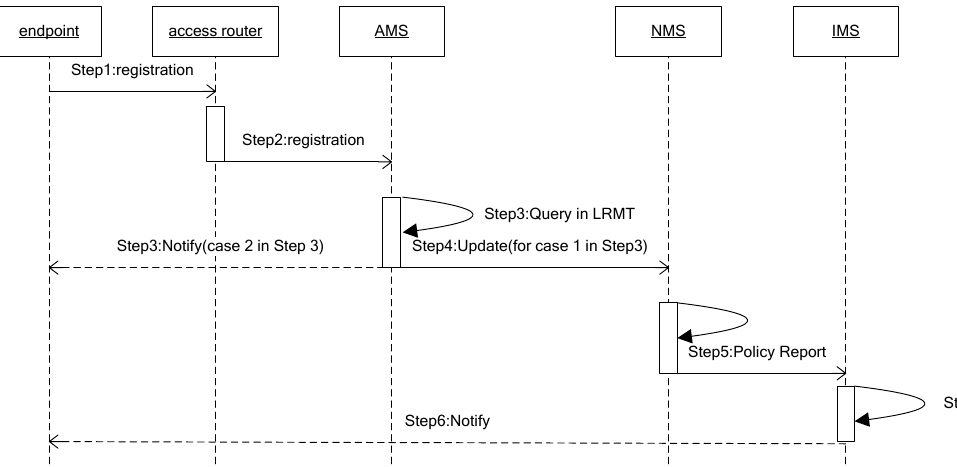
Figure 3. Mapping item initialization, update, and policy report (PR).